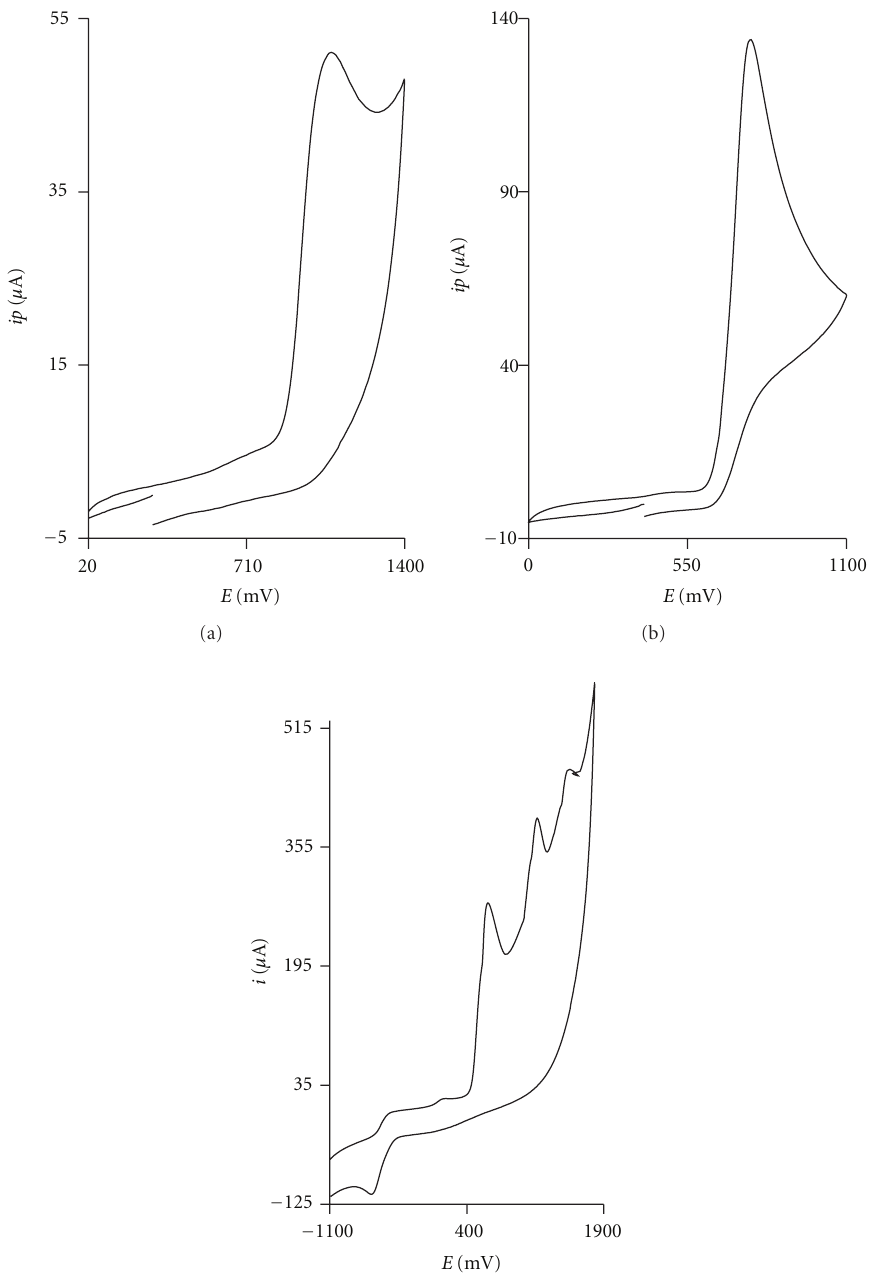
Figure 4: Cyclic voltammogram of (a) ASA, (b) AAP, and (c) DP at pH 1.0 on